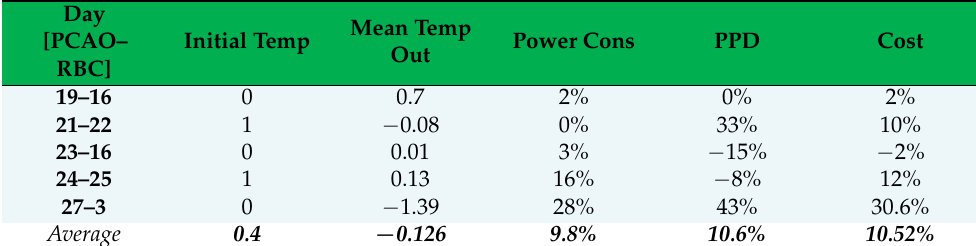
Table 15. Overall aggregated comparison results (winter).